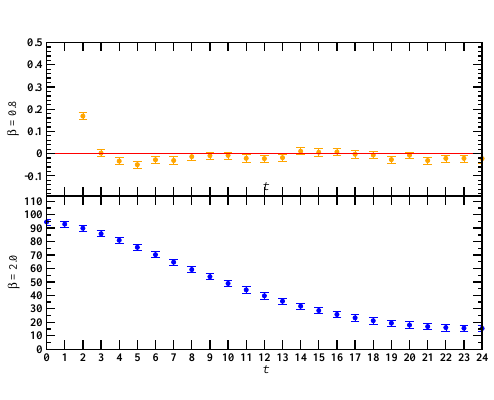
Figure 5. The photon Schwinger function in the confined phase (upper plot) and in the deconfined phase (lower